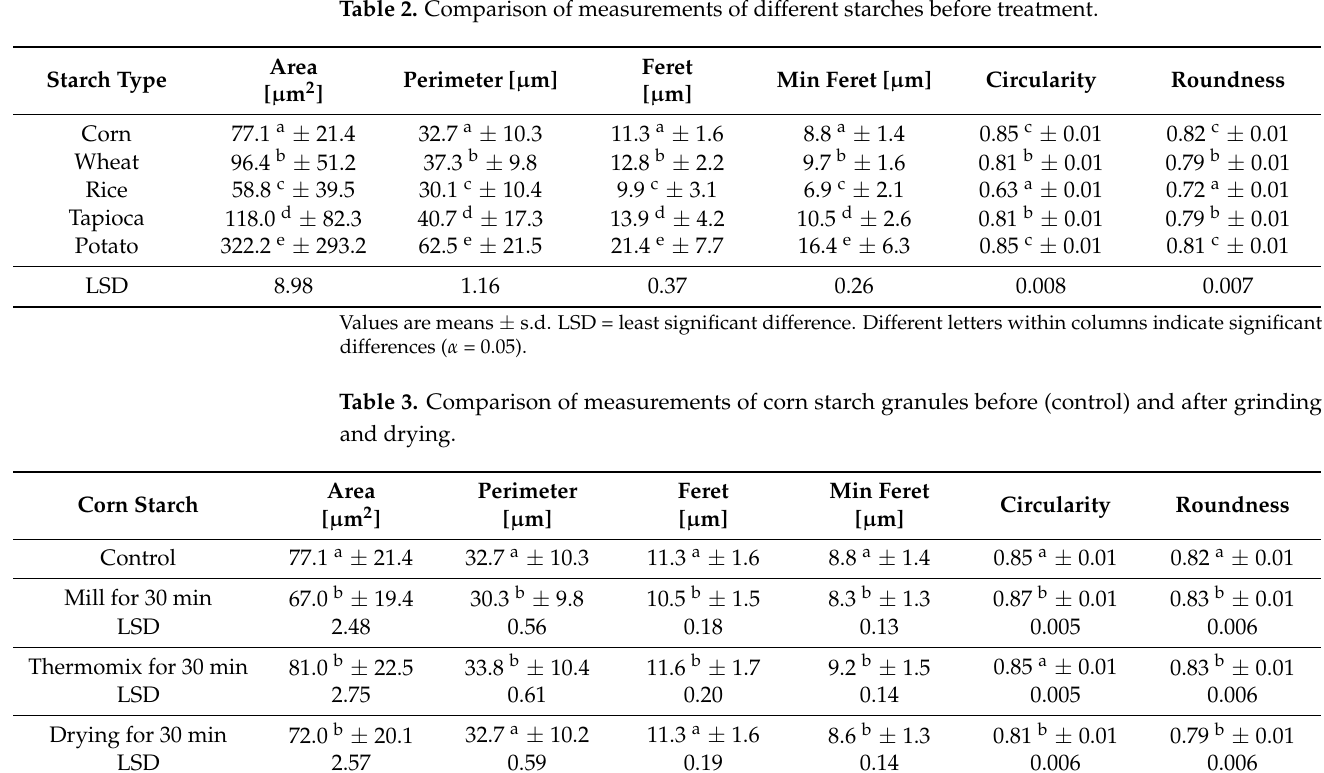
Table 2. Comparison of measurements of different starches before treatment.